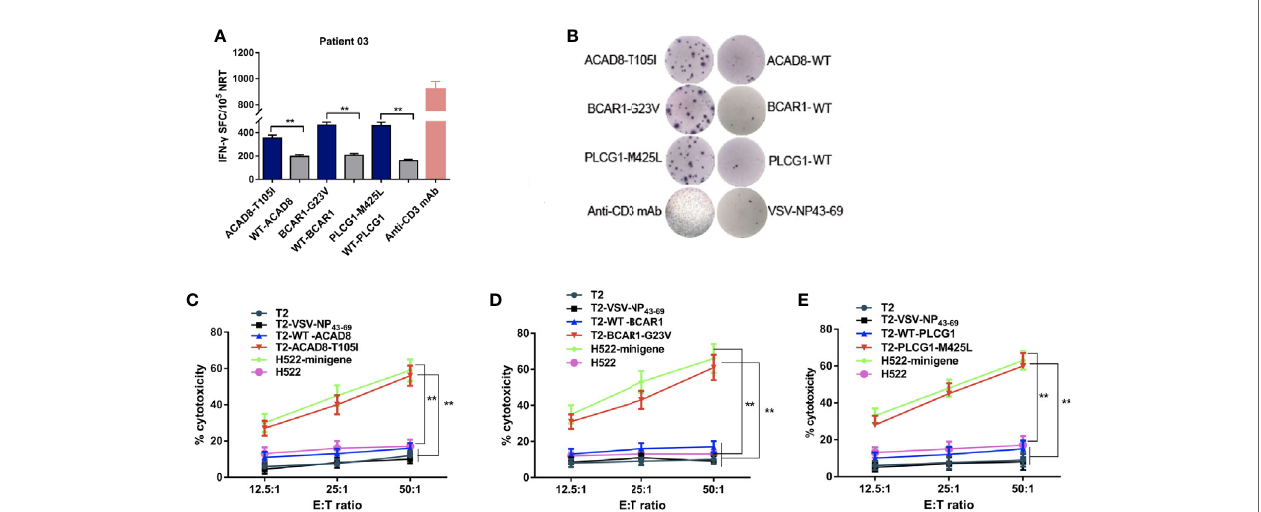
FIGURE 3 | Cytotoxicity of NRTs obtained from the in vitro stimulation of PBLs of HLA-A*0201-positive patient 03 with NSCLC. NRTs were induced with autologous ACAD8-T105I, BCAR1-G23V and PLCG1-M425L-pulsed DCs from PBLs of Patient 03 (P03). Seven days after the third stimulation, the NRTs were harvested for analysis. (A, B) IFN- g secretion by neoantigen-reactive T cell lines against mutated and wild-type peptides. IFN- g -positive SFCs/10 5 NRTs detected by cytokine-speci fi c ELISPOT assay. Stimulation with anti-CD3-mAb was used as positive control. (C – E) Cytotoxicity at the indicated E:T ratios measured using time- resolved fl uorescence assay. Mutant peptide-pulsed T2 cells and minigene-nucleofected H522 cells (HLA-A2.1 + , H522-minigene) were used as peptide-speci fi c targets, whereas irrelevant peptideVSV-NP43-69-pulsed T2 cells,T2 cells alone and H522 cells were used as controls. The data are presented as the means ± s.e.m.s from three independent experiments. ** P <0.01. NRTs, neoantigen-reactive T cells; WT, wild-type peptide; E:T, effector: target; PBL, peripheral blood lymphocyte; SFC, spot-forming cell; VSV-NP, vesicular stomatitis virus nucleoprotein.